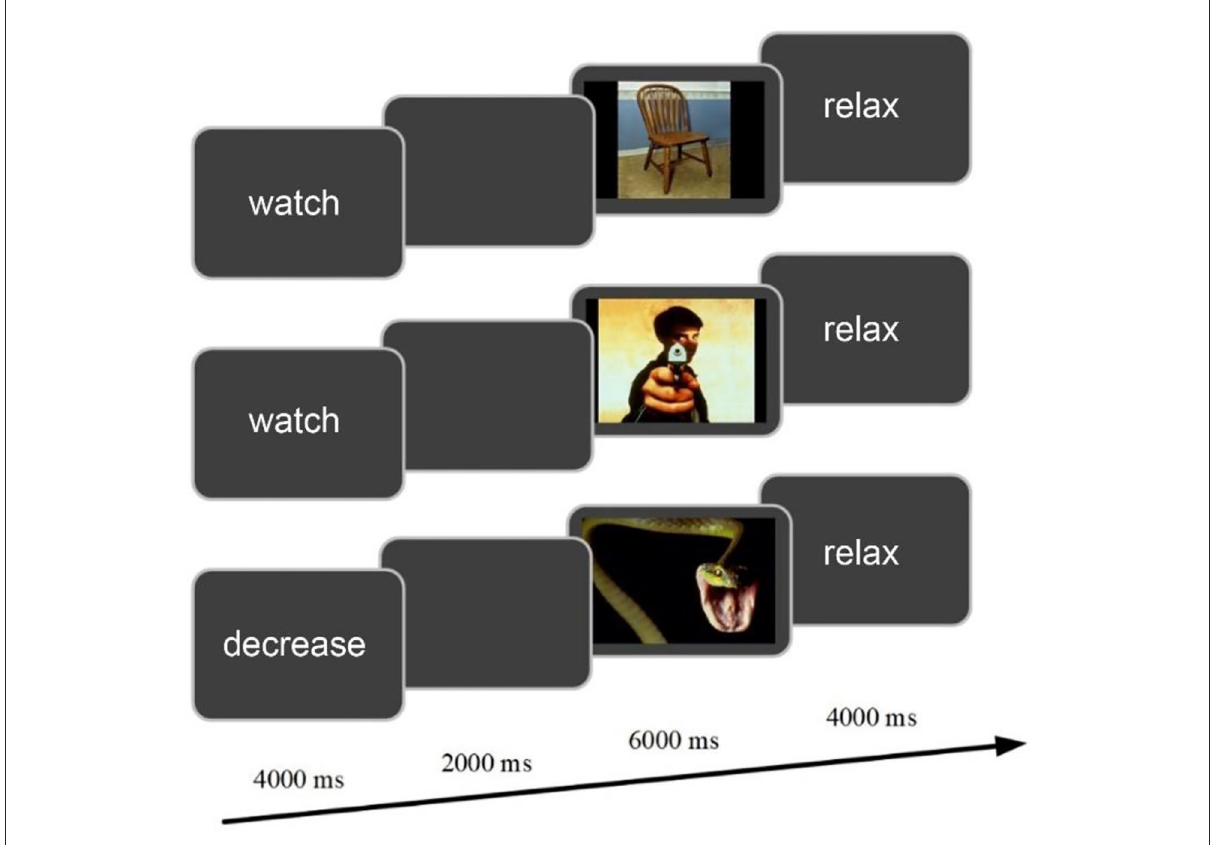
FIGURE1 The experimental design of cognitive reappraisal task for a single